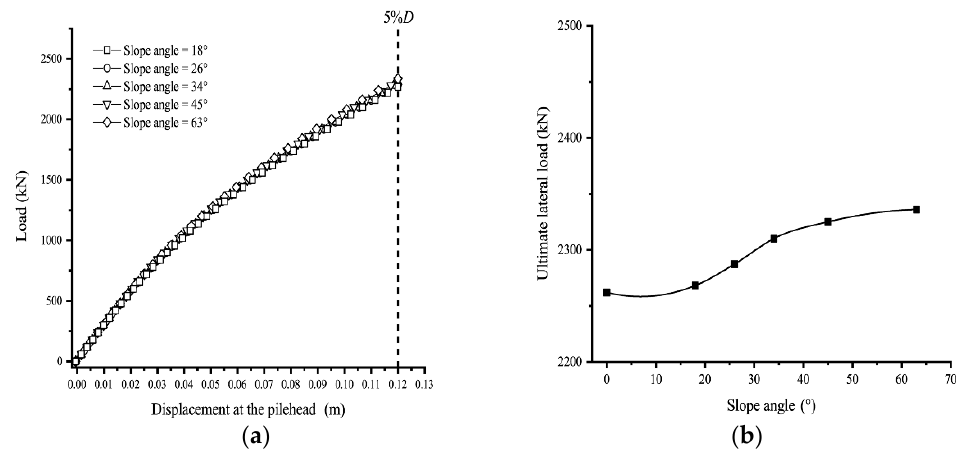
Figure 6. Slope angle effects on ( a ) load-displacement curves and ( b ) pile lateral load capacities.